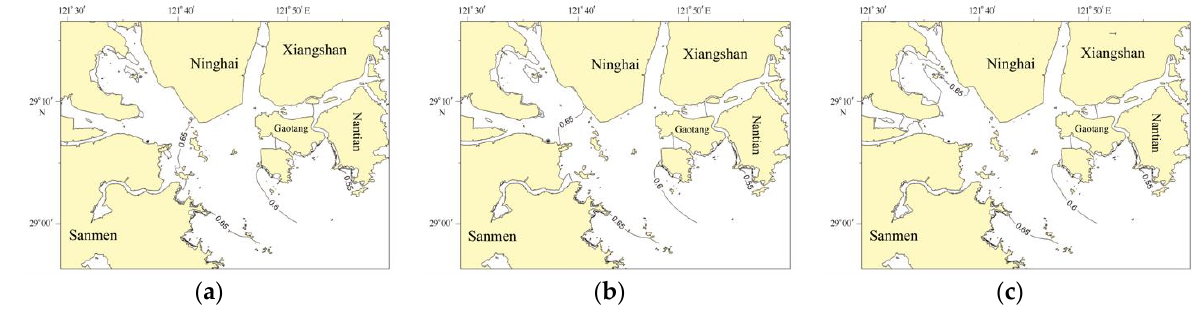
Figure 9. Result of source strength reduction in near term ( a ) mid-term ( b ) and long term ( c ). Table 8. Result of source strength